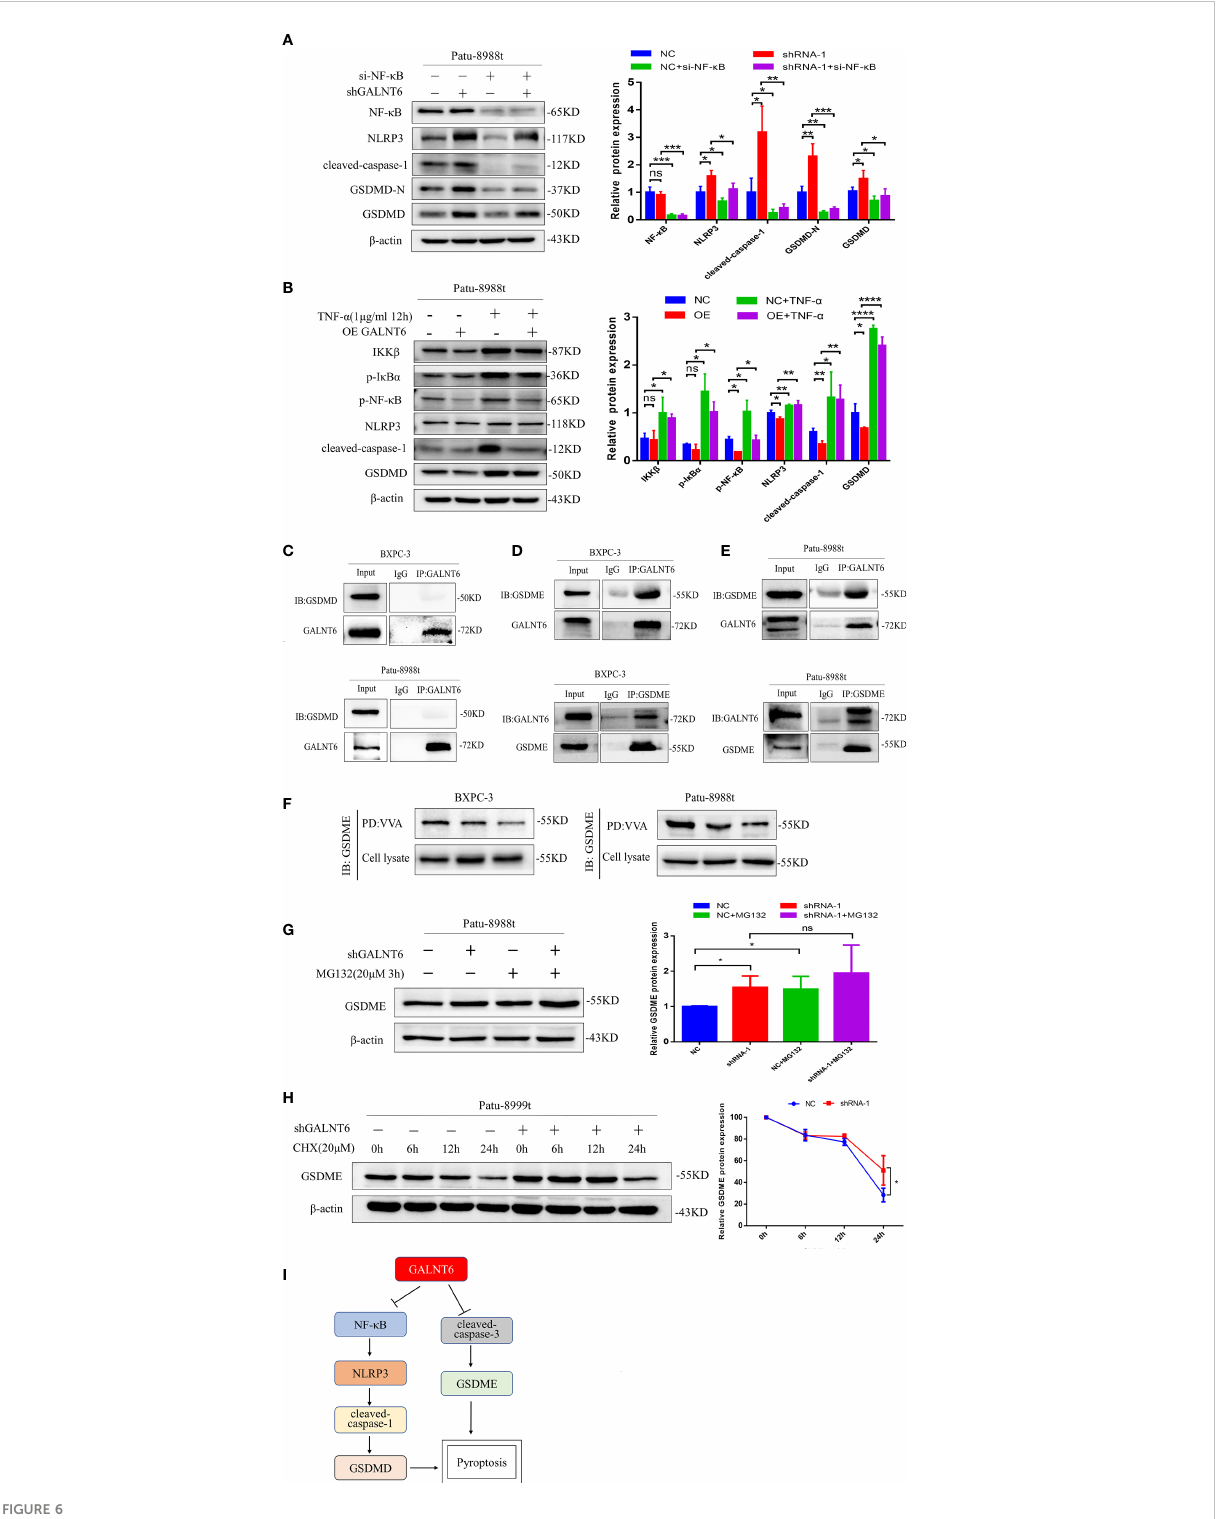
FIGURE 6 GALNT6 interacts with GSDME. (A) Western blot assay was used to detect the expression of NF- k B, NLRP3, cleaved-caspase-1, GSDMD-N and GSDMD in Patu-8988t cells after knockdown of NF- k B. (B) Western blot assay was used to detect the expression of IKK b , p-I k B a , p-NF- k B, NLRP3, cleaved-caspase-1 and GSDMD in TNF- a treated Patu-8988t cells. (C) Co-IP assay was used to detect the interaction between GALNT6 and GSDMD in BXPC-3 and Patu- 8988t cells. (D, E) Co-IP assay was used to detect interaction between GALNT6 and GSDME in BXPC-3 and Patu-8988t cells. (F) VVA pull-down assay was used to detect glycosylation of GSDME in BXPC-3 and Patu-8988t cells. (G) Western blot assay was used to detect the expression of GSDME in Patu-8988t cells after MG132 treatment. (H) Western blot assay was used to detect the expression of GSDME in Patu-8988t cells after CHX treatment. (I) Pattern signal diagram of GALNT6 regulates the pyroptosis of PDAC cells via NF- k B and GSDME. Each experiment was repeated at least three times independently, and the experimental data were expressed as mean standard deviation (X ± SD). ns, p >0.05; *p <0.05; **p <0.01; ***p <0.001; ****p